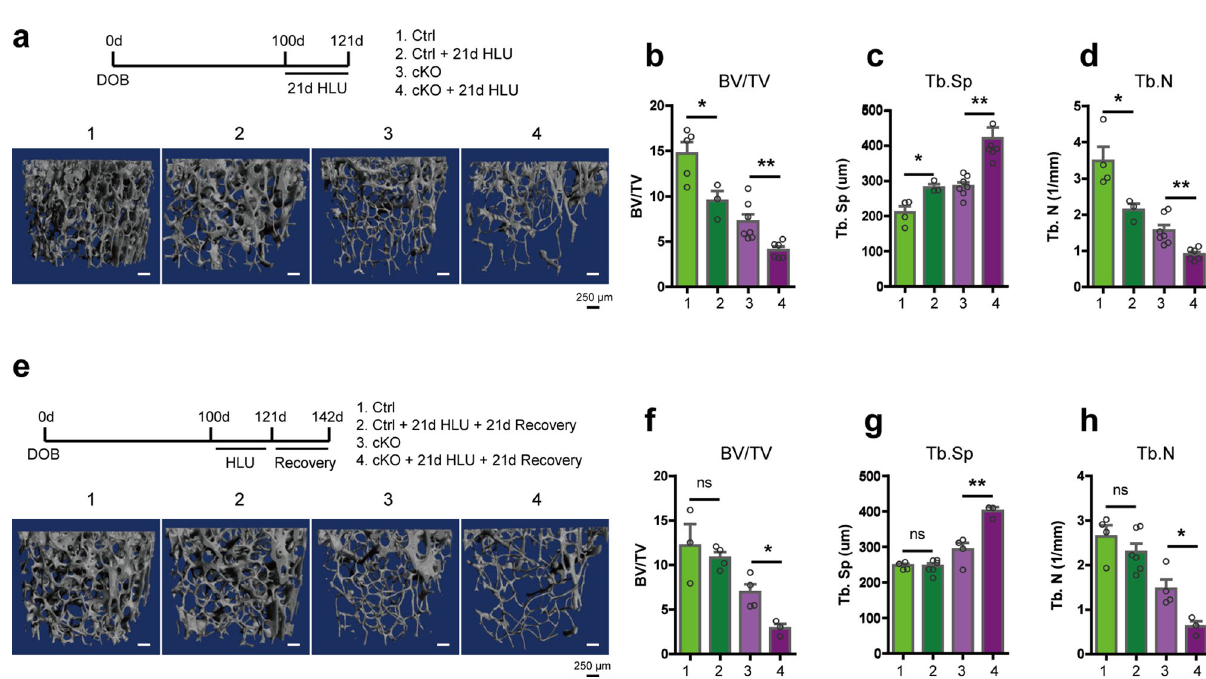
Fig. 3 Mice with Kindlin-2 loss in osteocytes fail to restore the hindlimb unloading (HLU)-induced bone loss. a μ CT 3D reconstruction of distal femur trabecular bone from control and cKO mice before and after 21 days ’ HLU experiment. N = 3 – 7 for each group. b – d Quanti fi cation of the trabecular bone from control and cKO mice in HLU experiments. e μ CT 3D reconstruction of distal femur trabecular bone from control and cKO mice in 21 days ’ HLU and 21 days ’ recovery experiment. f – h Quanti fi cation of the trabecular bone from control and cKO mice in HLU-recovery experiments. N = 3 – 6 for each group. * P < 0.05, ** P < 0.01, *** P < 0.001, versus controls, Student ’ s t test. Results are expressed as mean ± standard deviation